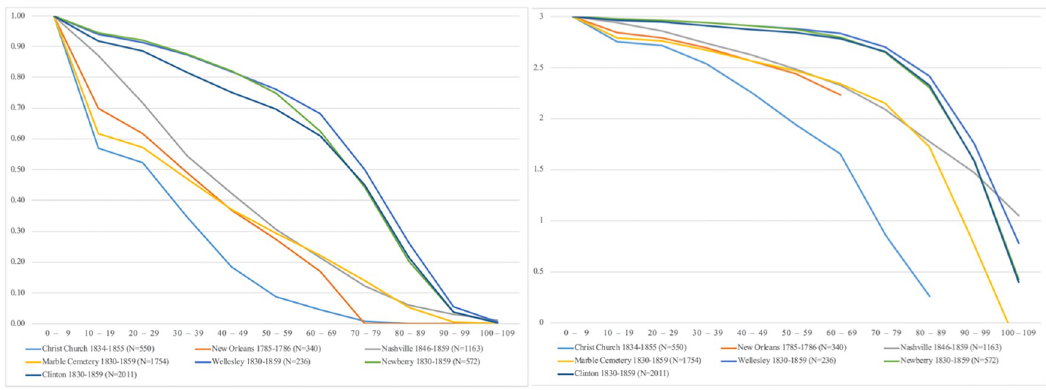
Fig 5. Christ Church demographic profiles. Left: percentage surviving (l(x)) per 10-year age classes in comparison to contemporaneous urban and rural cemeteries. Right: Log survivorship (l(x)) curves. See Table 1 for values.